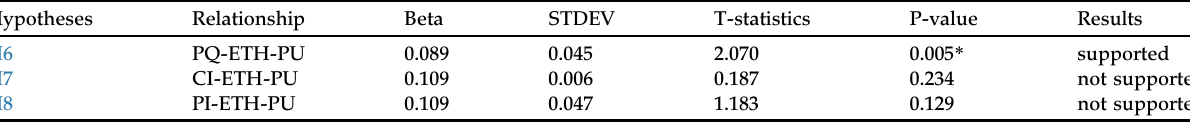
Table 5. Moderation test